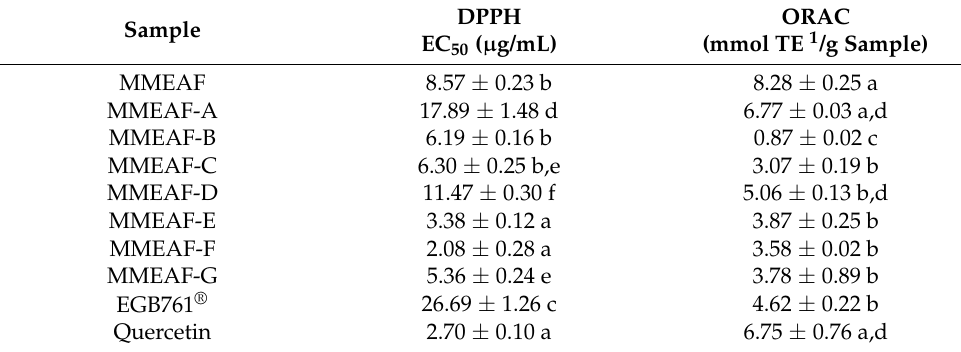
Table 3. Antioxidant effect of MMEAF and subfractions assessed by DPPH and ORAC assays. DPPH Sample EC 50 ( µ